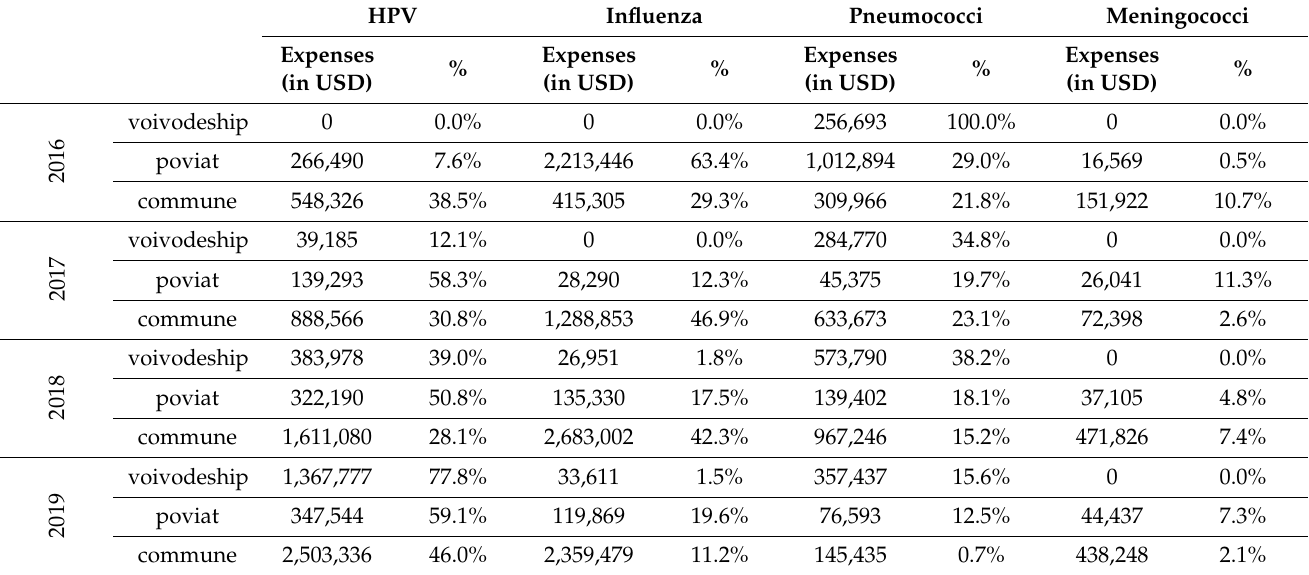
Table 3. Expenses on immunization programmes implemented between 2016 and